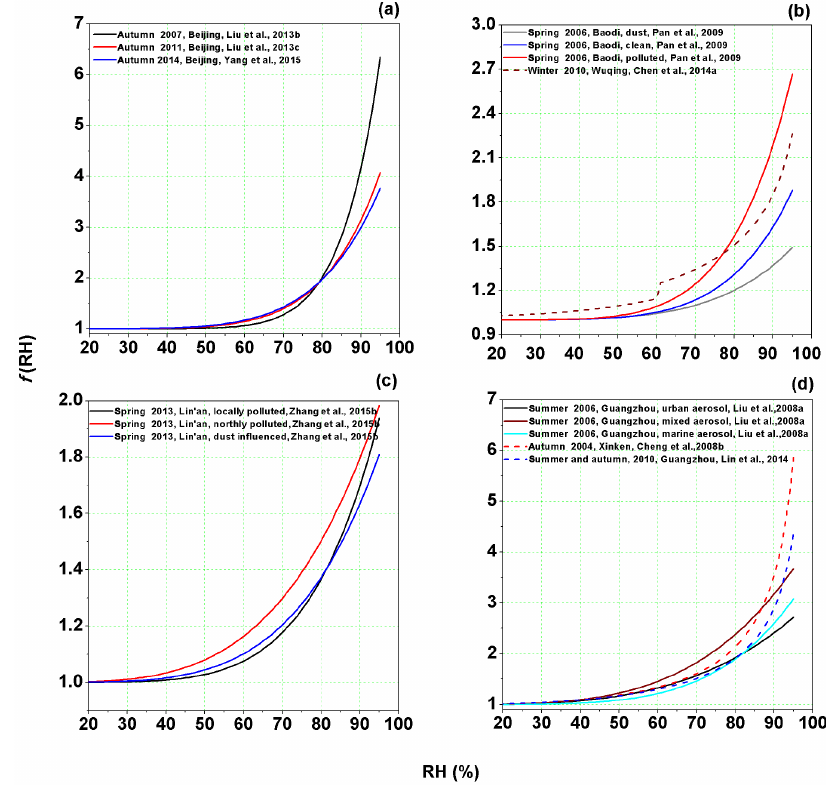
Figure 14. The hygroscopic growth curves in different sites in